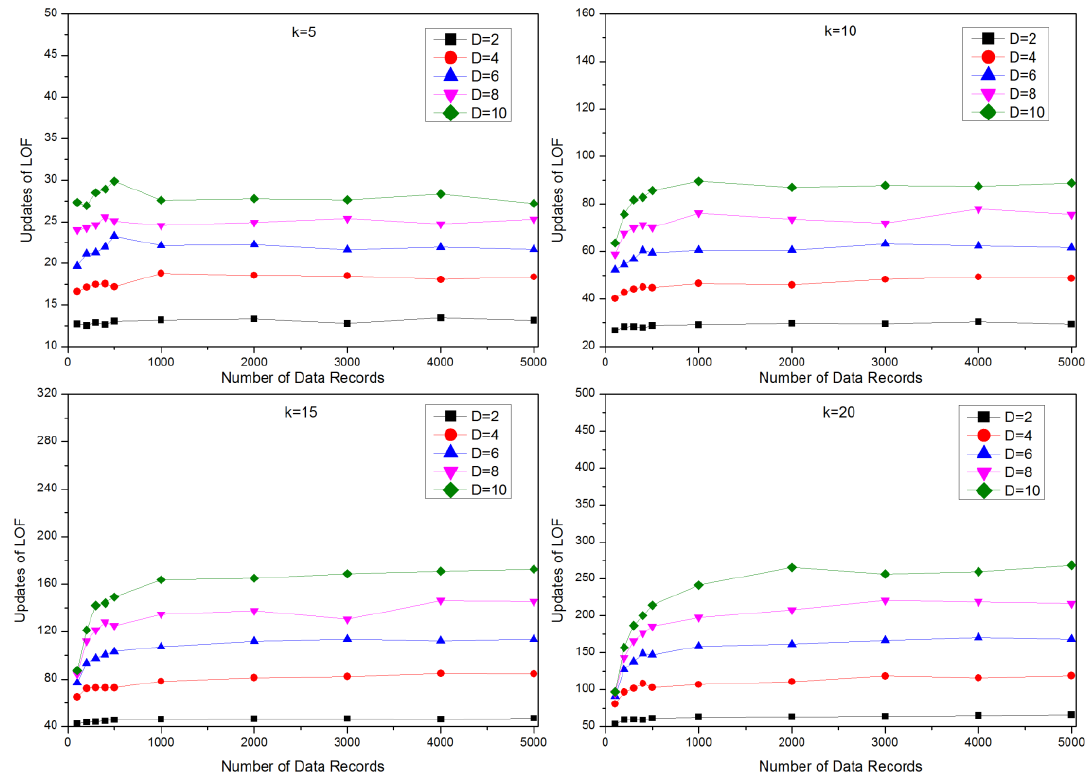
Figure 4. The dependence of the number of CLOF updates on the total number of data records N , data dimension D , and parameter k in uniform distribution.